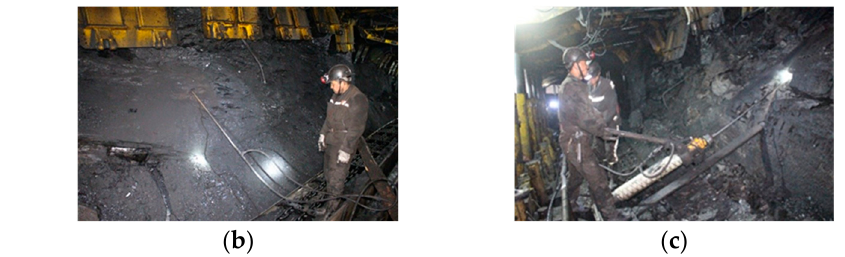
Figure 13. On-site grouting schematic diagram. ( a ) Grouting pump and connecting injection gun; ( b ) Connection between grouting pipe and grouting gun; ( c )